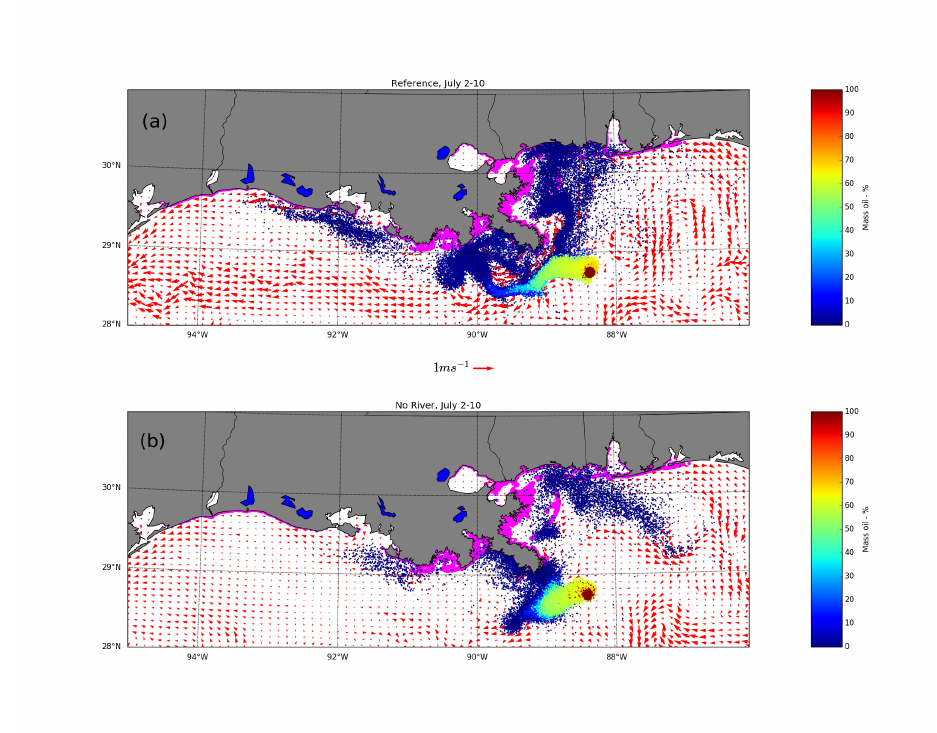
Figure 11. End condition of the simulation 2–10 July 2010, showing active (at surface) and stranded oil elements. Stranded oil is shown in magenta. The color scale indicate how much mass is left in each element. Red arrows are the GoM-HYCOM 1/50 surface currents at the last time step of the simulation (every 2nd data point shown). Reference simulation in ( a ) (48.1% stranded oil), and no river simulation in ( b ) (55.1% stranded oil) (see also Table